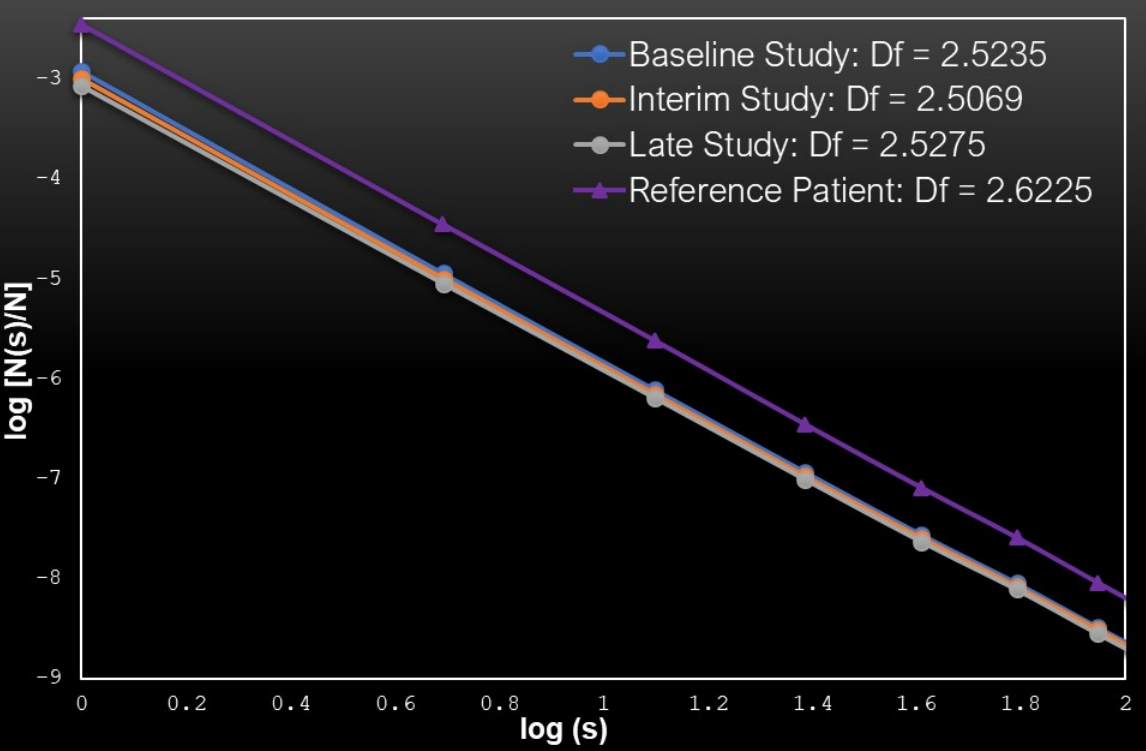
Figure 1. The normalized number of boxes N(s)/N which contain the tracer as a function of the box size s in a double logarithmic scale. The blue line corresponds to the baseline study of patient P9, the orange line to the interim study and the gray line to the final study of the same patient. For comparison the purple line representing healthy control H3 is also depicted.